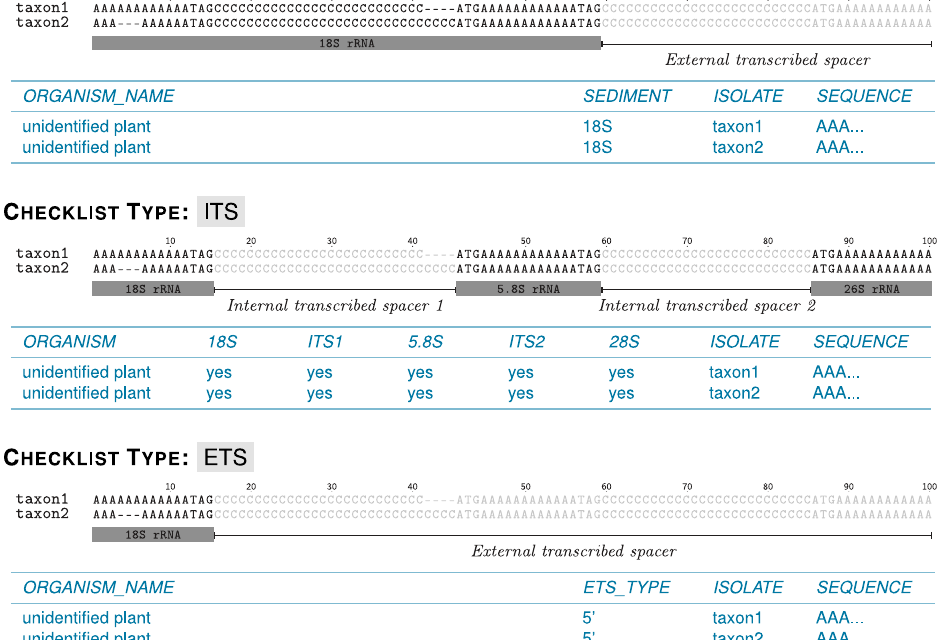
Fig 2. Structural overview of the six DNA markers and their corresponding Webin checklists as implemented in EMBL2checklists. The overview displays the structural characteristics of each DNA marker (in black) and the idiosyncratic column names and column values (in blue) of the corresponding checklists. The column names and column values of each checklist are also presented in Table 2, where they are cross-referenced with the mandatory annotation features and feature qualifiers of the input flat files. The DNA sequences displayed here represent dummy sequences and are identical to the sequences of the example test files co-supplied with the software.